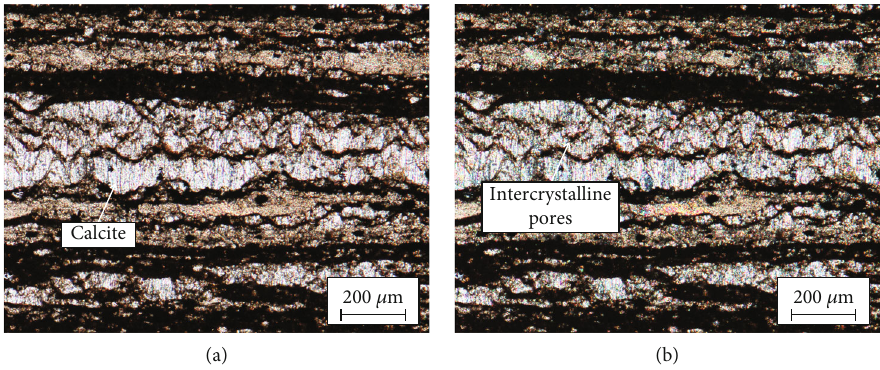
Figure 8: Characteristics of intercrystalline pores in the Es4u shale in the Dongying Depression. (a) Recrystallized intercrystalline pores. During the recrystallization process of calcite, the crystal volume becomes smaller, thus forming recrystallized intercrystalline pores. (-), 3397.5m. (b) Recrystallized intercrystalline pores. The pore size is about 10 μ m, and some of the pores are fi lled with oil. (+),